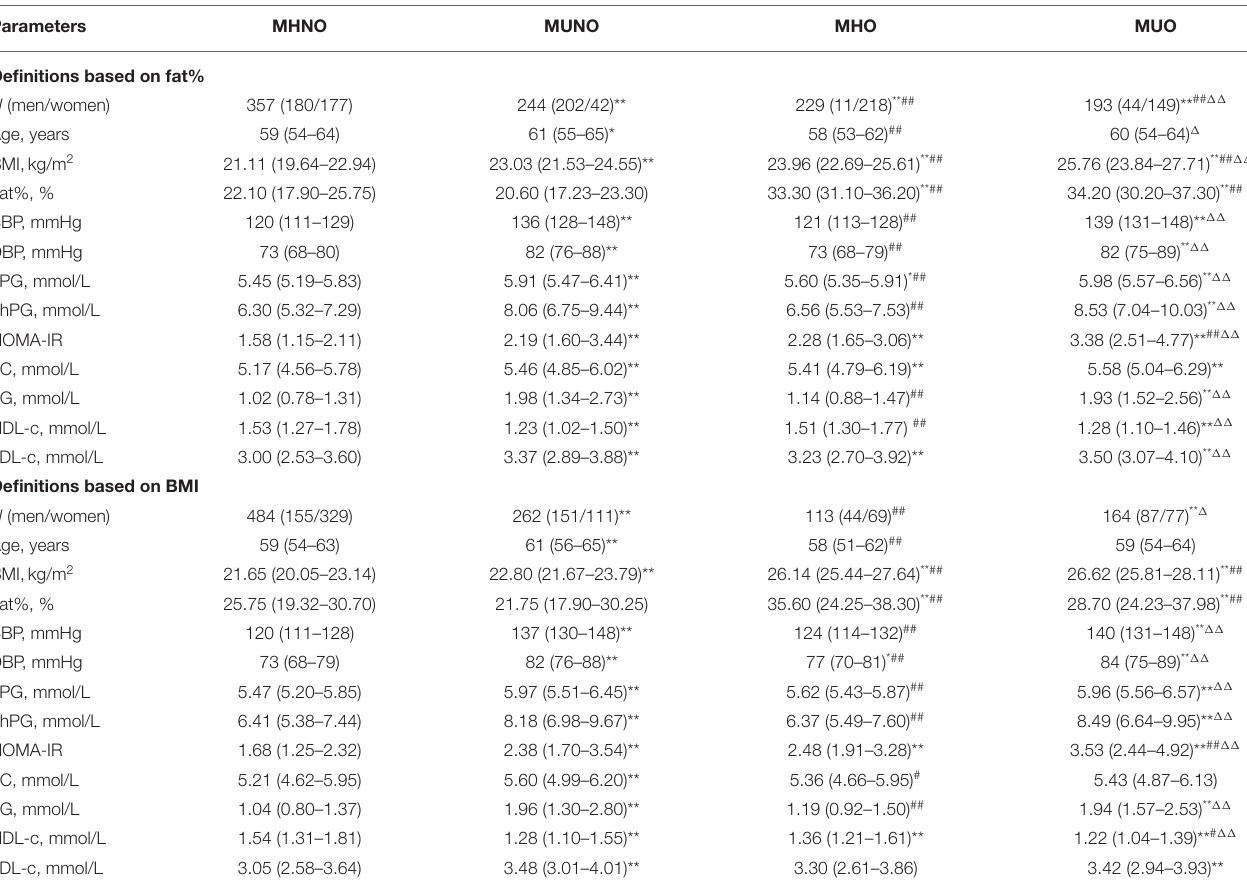
TABLE 1 | Clinical characteristics according to different metabolic phenotypes of